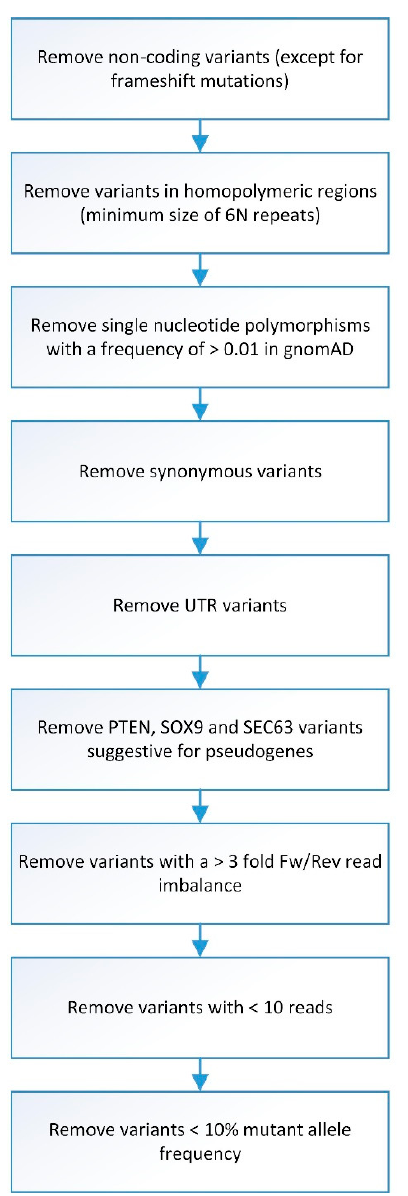
Figure 1. Flowchart of smMIP analysis data filtering. Overview of steps involved in data filtering before smMIP data analysis was performed.